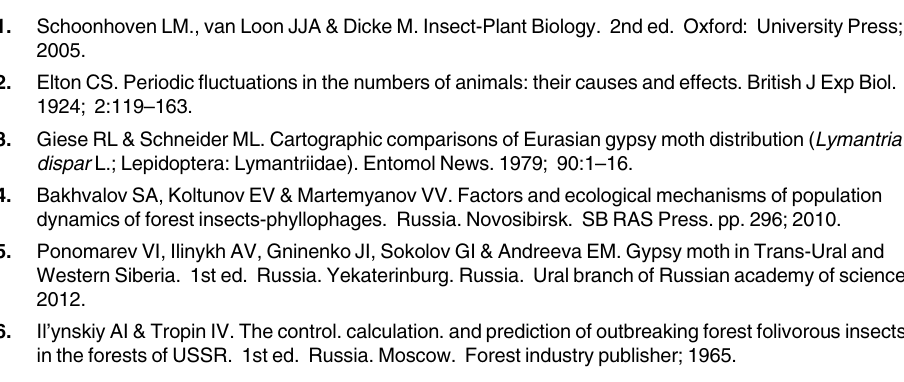
S3 Fig. Image illustrating the special feature of overwintering of Siberian populations of Lymantria dispar . S1 Table. The characteristics of cross-correlation functions between comparing districts of the Novosibirsk oblast. The value of function/t-value are above the main diagonal and the temporal delay (k, years) is